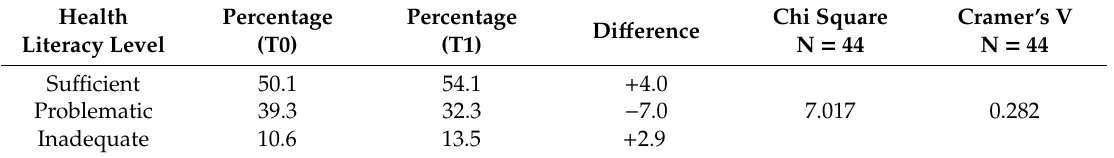
Table 9. Proportion of teachers with di ff erent levels of health